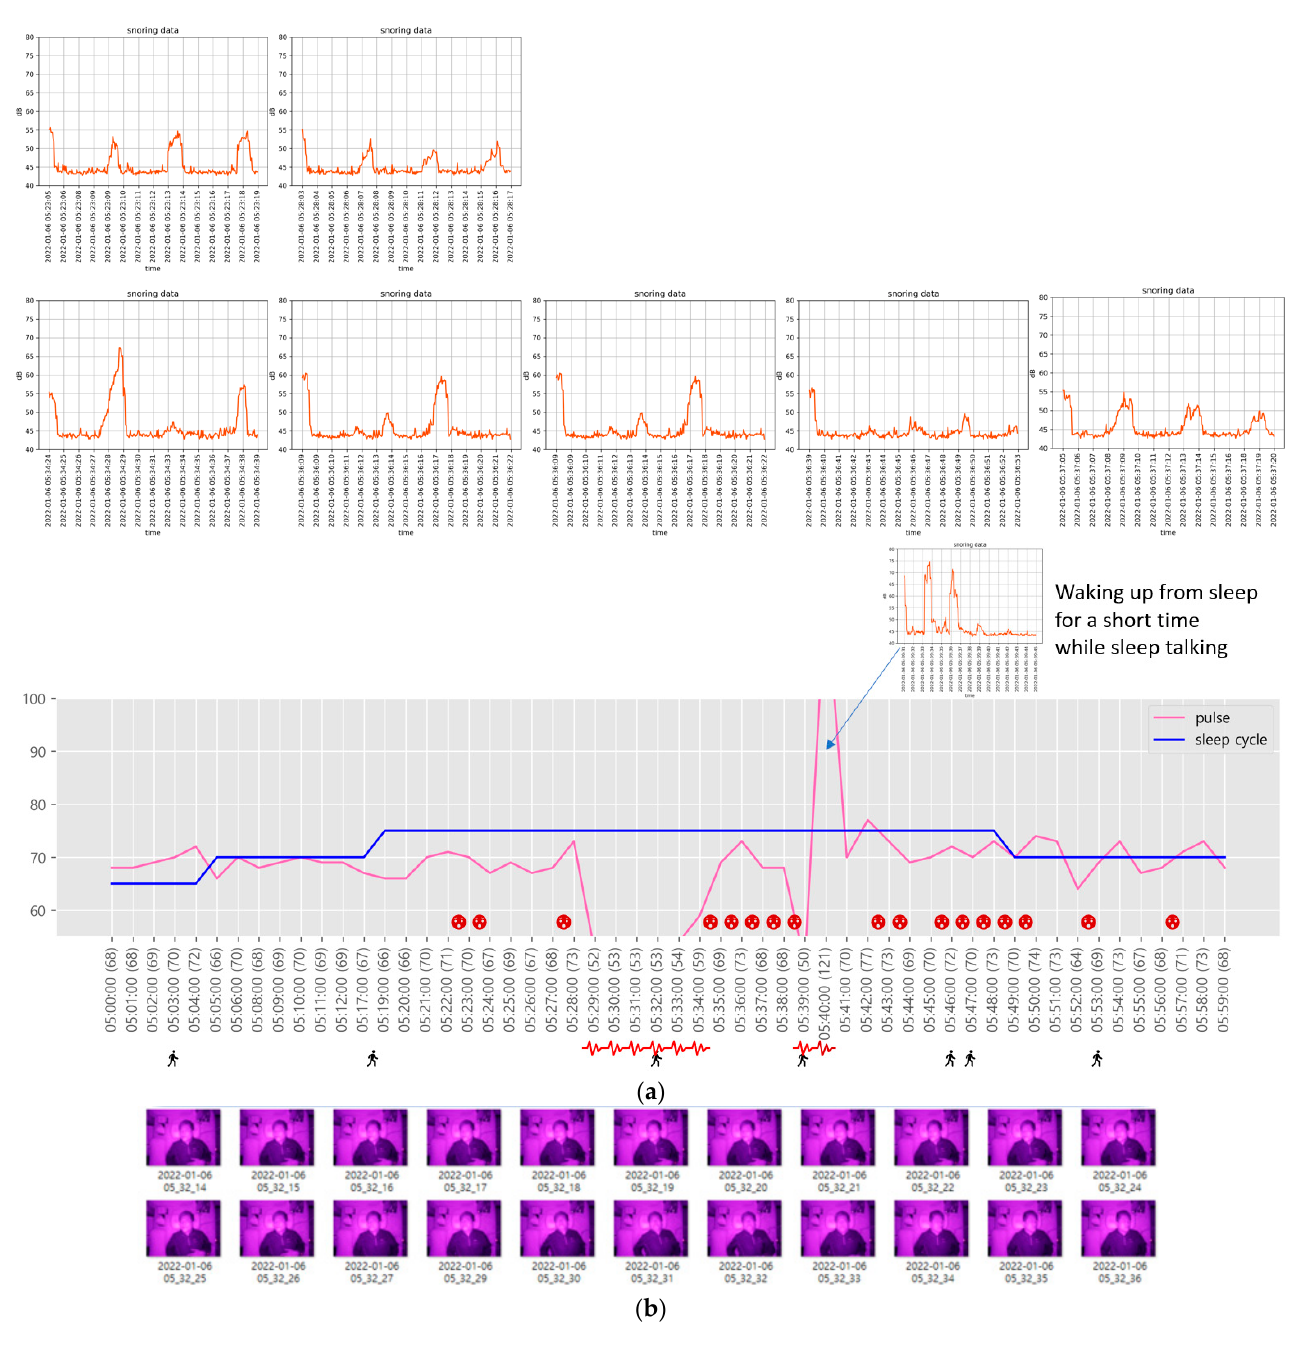
Figure 20. Sleep-related information in the section predicted by the REM sleep stage. ( a ) Sleep-related information during the predicted REM sleep stage; ( b ) 22 snapshots of sleep postures captured from 05:32:14 to 05:32:36.